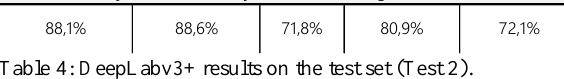
Table 5: DeepLabv3+ results on the test set (Test 3).